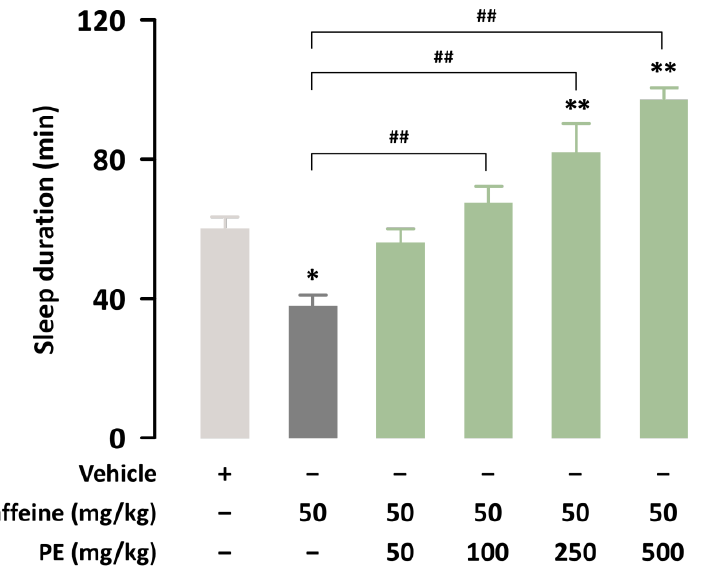
Figure 2. Effects of co-administration of PE and caffeine on sleep duration in pentobarbital-treated ICR mice. Each value represents the group mean ± SEM ( n = 10 per group). * p < 0.05, ** p < 0.01, significant difference compared to the vehicle group (Tukey’s test). ## p < 0.01, significant difference compared to the caffeine-alone-treated group.